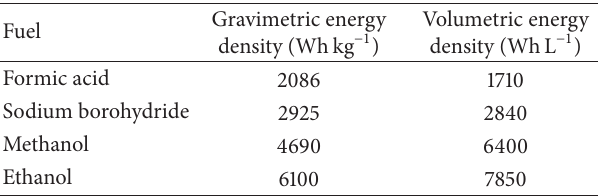
Table 2: Summary of the theoretical energy densities for different